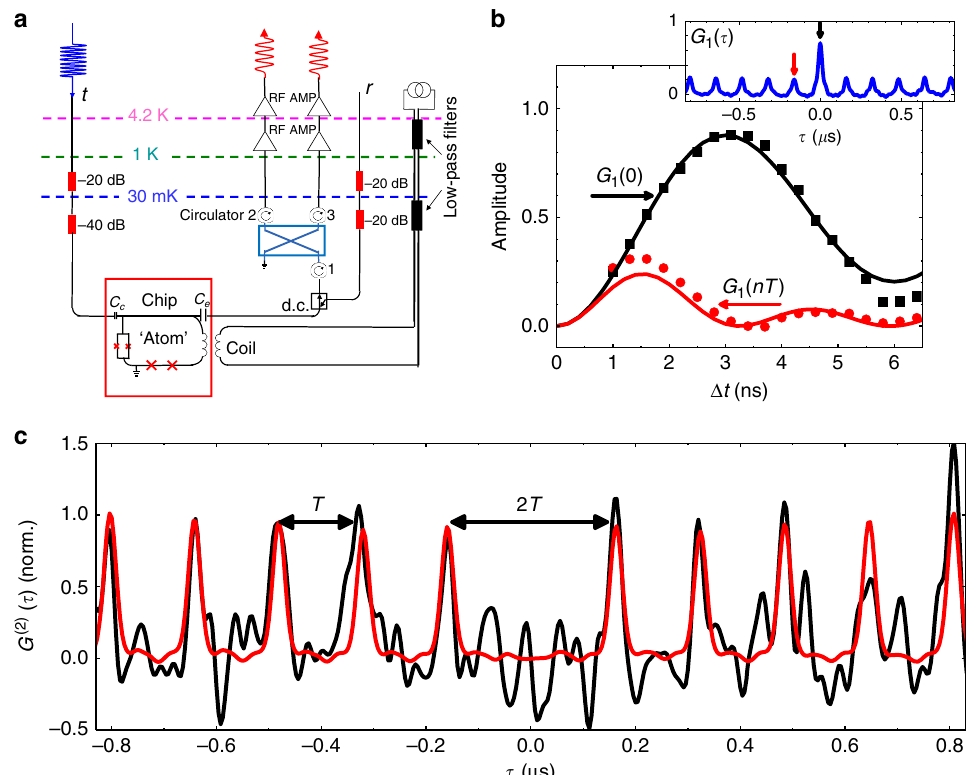
Figure 4 | Correlation function measurements. ( a ) The experimental setup for Hanbury–Brown–Twiss measurements with linear detectors in the microwave frequency domain. ( b ) The first-order correlation function dynamics. The inset shows typical G 1 ð Þ t ð Þ . The black squares and red dots represent experimentally measured dynamics of central peak G (1) (0) and side peaks G (1) ( nT ), respectively. The solid curves show simulations with the actual device parameters, including dissipation. ( c ) The black curve is measured second-order correlation function G 2 ð Þ t ð Þ and the red one represents the simulated second-order correlation function using the measured photon traces. The second-order correlation function is a result of averaging of 1.5 (cid:3) 10 10 traces with 1,600 points in each trace with 4ns sampling rate. The curves are then additionally smoothed out. The result of g 2 ð Þ t ð Þ measurements after averaging of 1.5 (cid:3) 10 10 traces is shown in Fig. 4c, where the function G 2 ð Þ t ð Þ is obtained from g 2 ð Þ t ð Þ by subtracting the background and normalization.